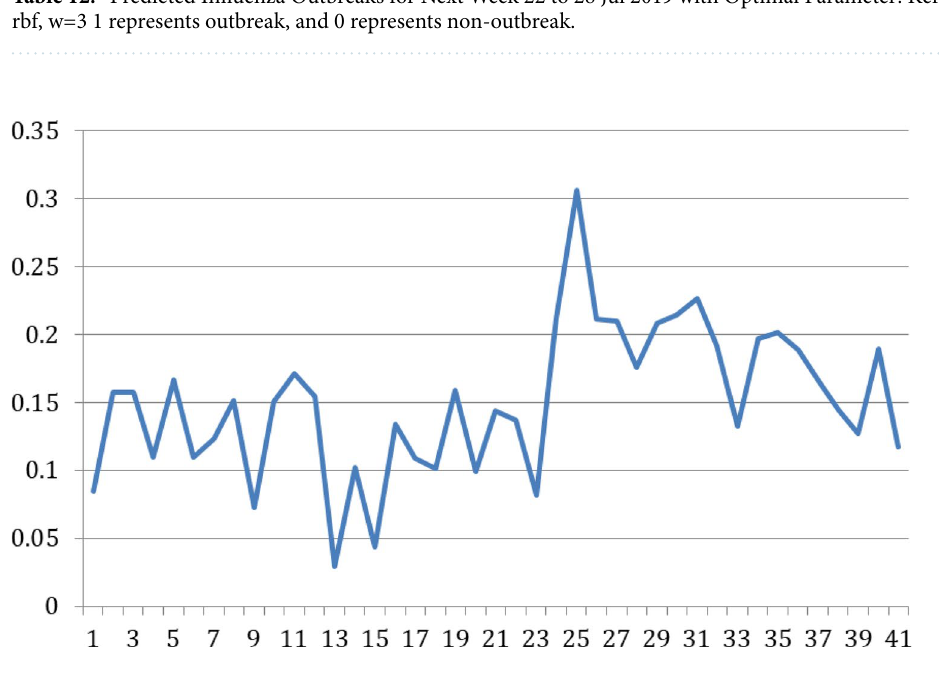
Figure 9. WHO weekly influenza rate in